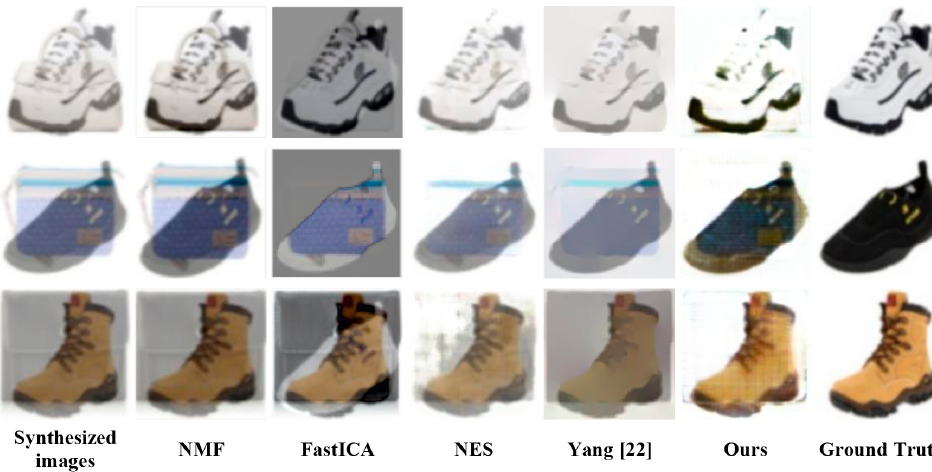
Figure 5. Result of image separation for synthesized images. Table 1 lists the objective measurement results for each set of experiments. In Table 1, we can see the PSNR (dB)/SSIM scores of several image separation methods on these two datasets. The separated image is said to be closer to its ground truth if it has a higher PSNR value, while a higher SSIM score means that the result is more similar to its refer- ence image in terms of image brightness, contrast and structure. It can be observed from Table 1 that the proposed method achieves the best performance on two of the datasets, and outperforms NMF, FastICA, NES, and Yang et al.’s method with respect to both PSNR and SSIM. This substantiates the flexibility and generality of our proposed method in di- verse mixing types contained in these datasets. Table 1. Shoe and bag image results (PSNR, SSIM).